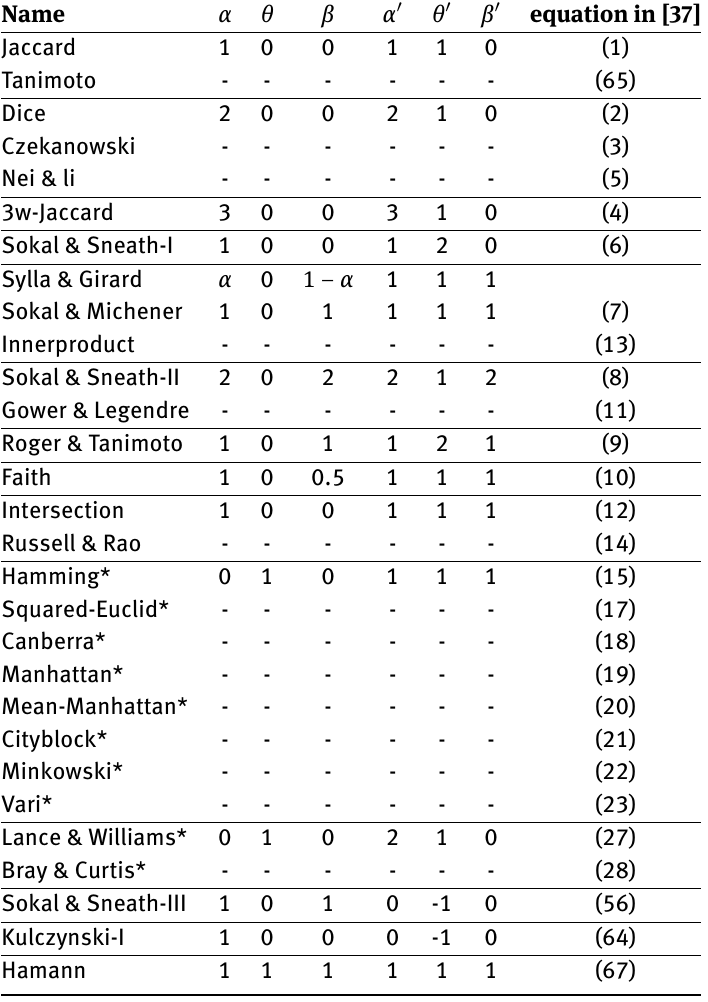
Table 1: Similarity measures. Measures marked with * are obtained by taking the opposite of the associated dissimilarity mea- sures. The last column refers to the equation number in